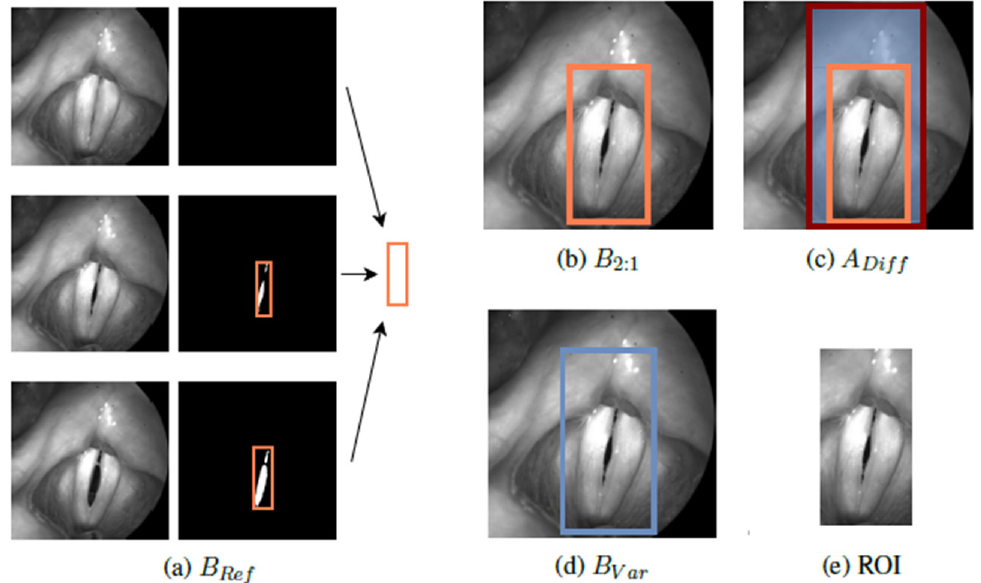
information (Figure 6d,e).